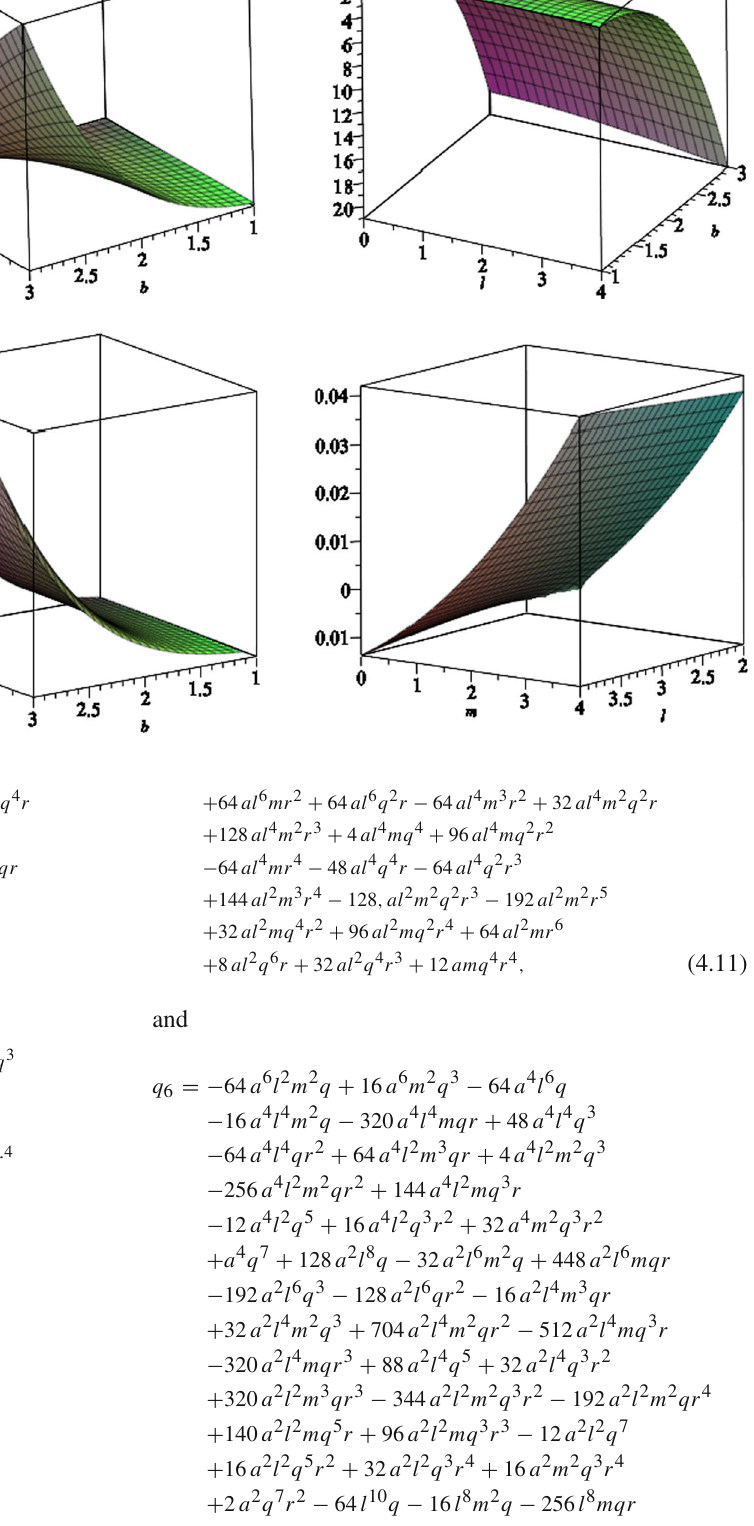
Fig. 12 The angular velocity of the horizon as function of a , b (left) and l , b (right), where we set the other black hole parameters to a set of fixed numbers